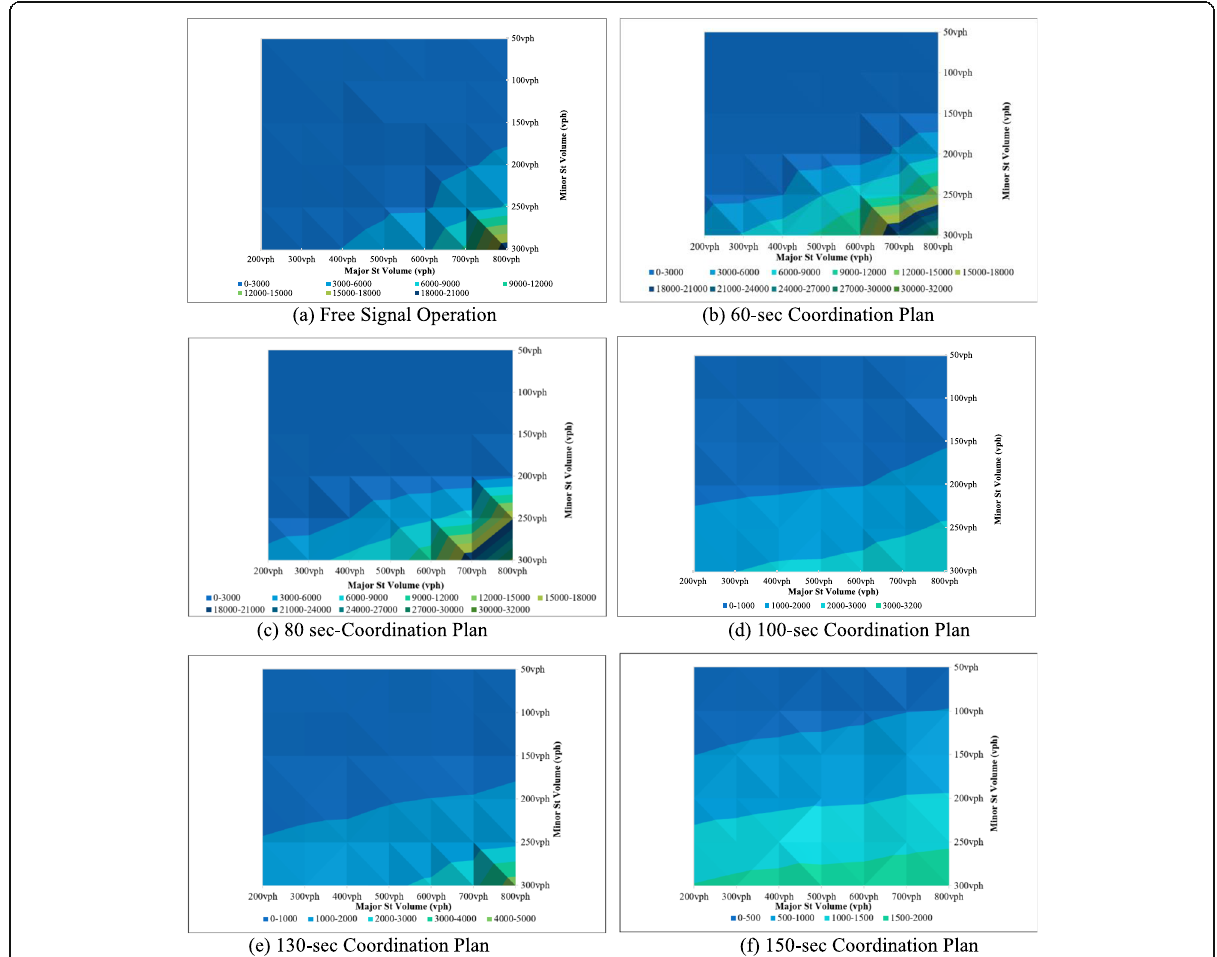
Fig. 6 Simulated Number of Conflicts at North McCarran Blvd under Various Demand Scenarios. a Free Signal Operation. b 60-s Coordination Plan. c 80 s-Coordination Plan. d 100-s Coordination Plan. e 130-s Coordination Plan. f 150-s Coordination